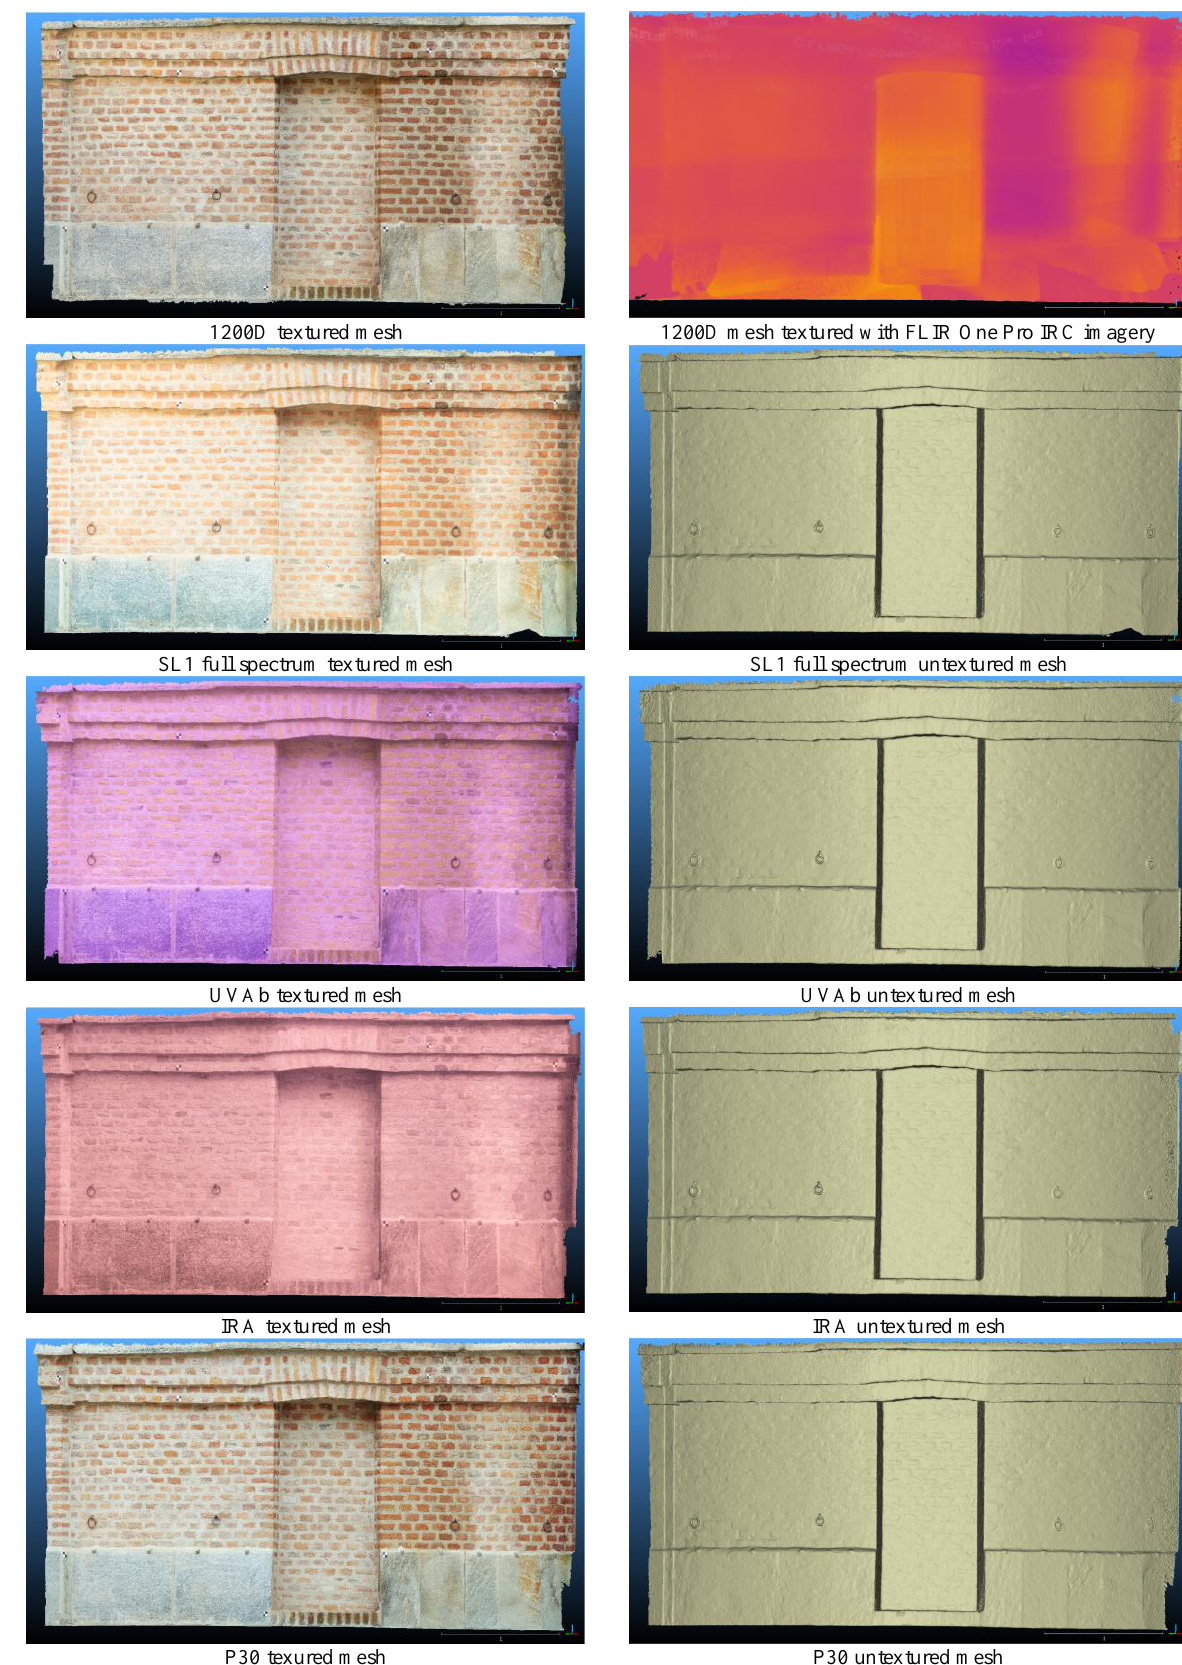
Figure 8: Agisoft Metashape results for